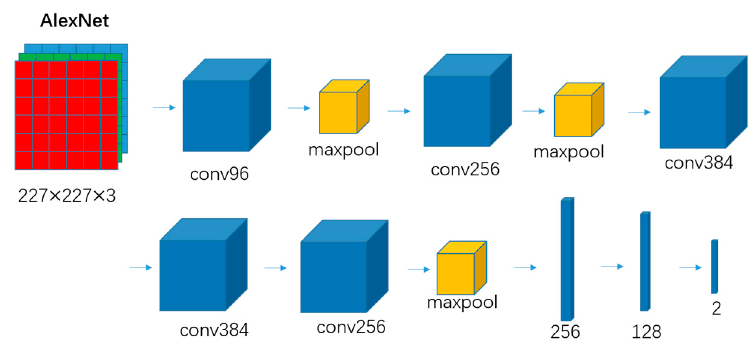
Figure 3. AlexNet model.